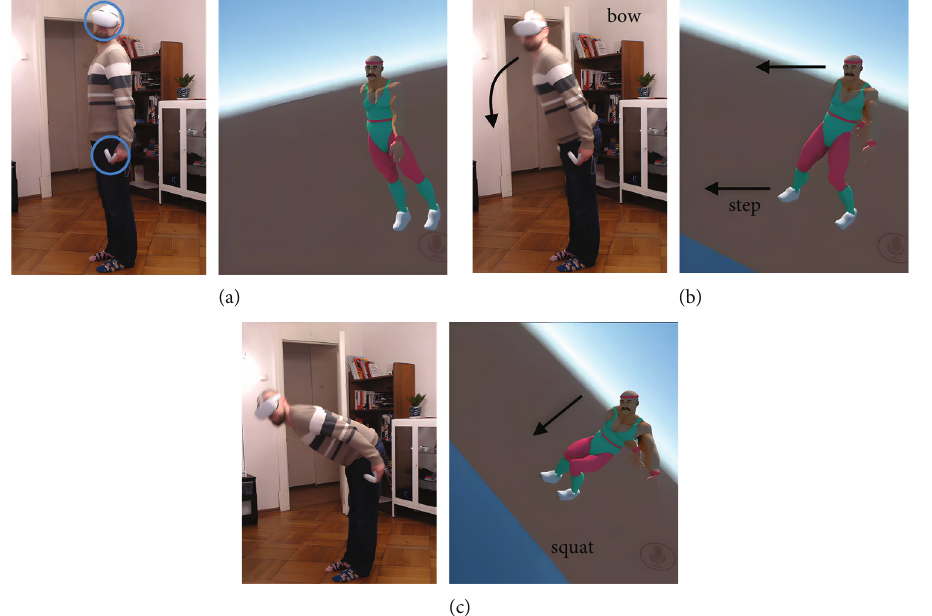
Figure 3: Three-point IK. Physical recording (left) and the way it translates into VR